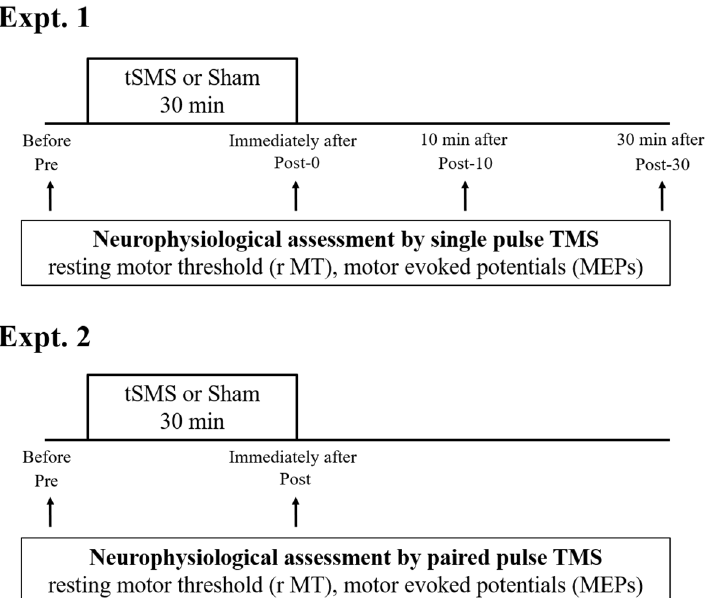
Figure 1. Experimental procedures. TSMS or sham stimulation was applied over the left M1 for 30 min in Expt. 1 and 2. For Expt. 1, neurophysiological assessment by single-pulse TMS was performed at before (pre), immediately after (Post-0), 10 min (Post-10) and 30 min (Post-30) after tSMS or sham stimulation. At each point, rMT and MEP were measured from the both hands respectively. For Expt. 2, we measured the IHI using paired-pulse TMS before (Pre) and immediately after (Post) tSMS or sham